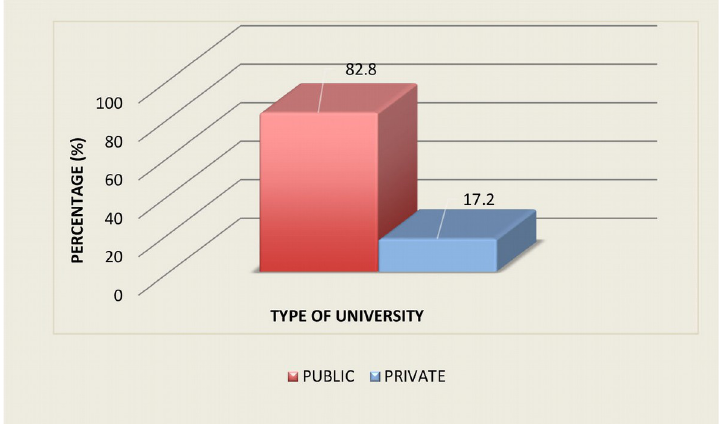
Figure 2. Percentage of subjects with content on the didactic use of cinema according to the type of university